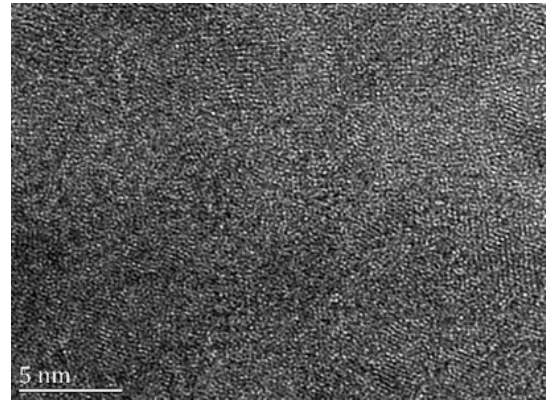
Figure 3. High-resolution electron microscope (HREM) micrograph of Fe 88 Zr 8 B 4 sample.